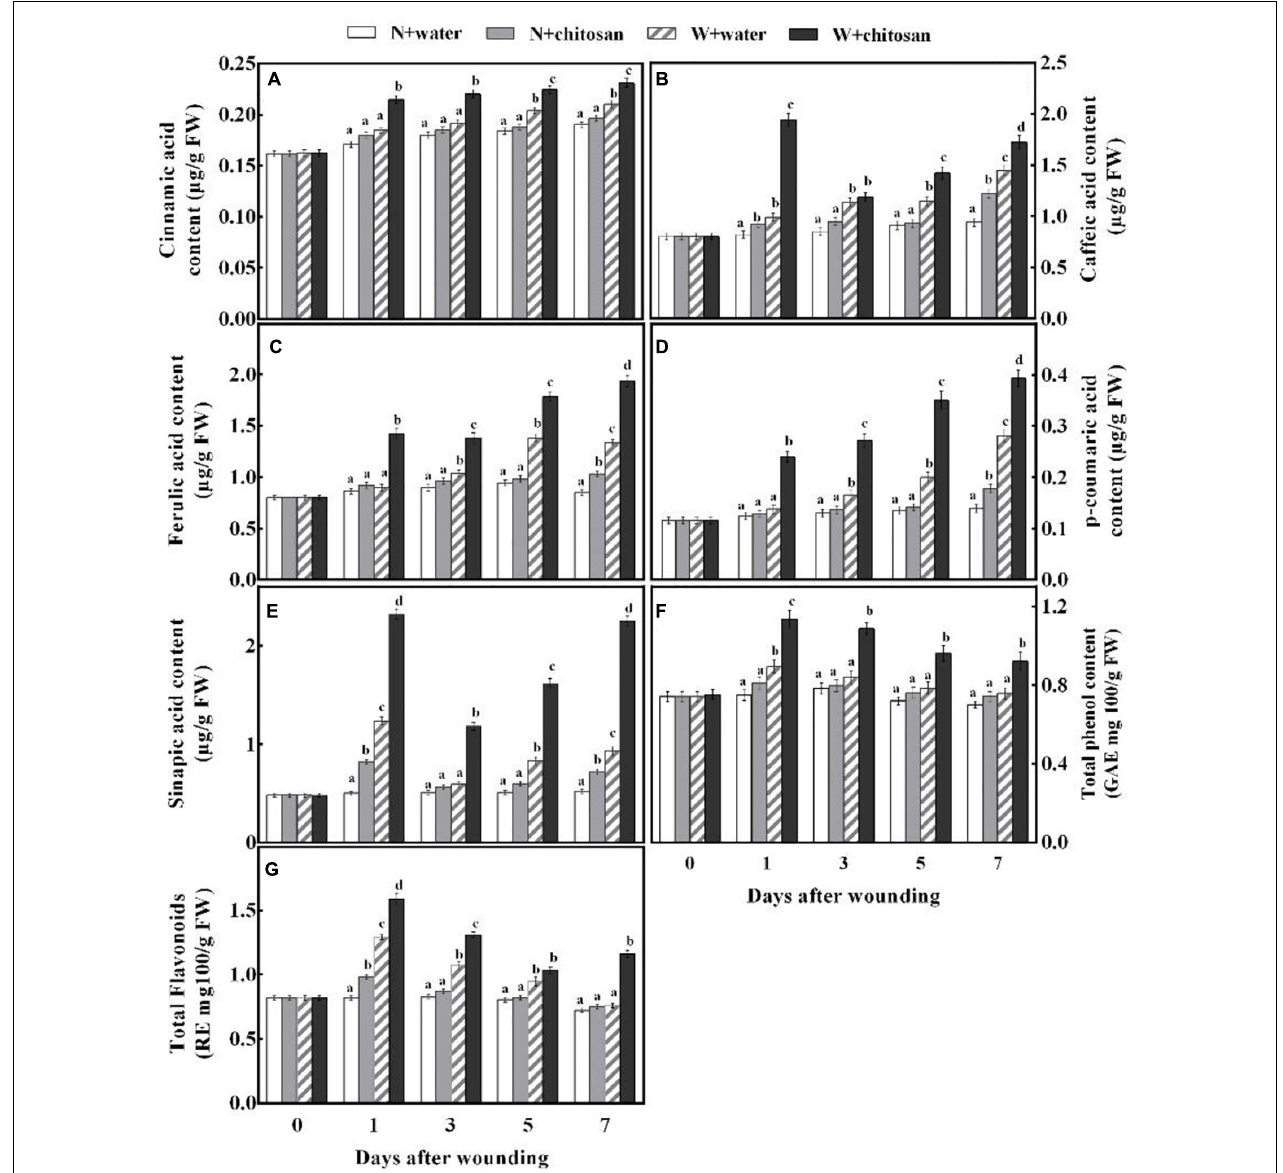
FIGURE 4 | Effect of chitosan treatment on contents of cinnamic acid (A) , caffeic acid (B) , ferulic acid (C) , p -coumaric acid (D) , sinapic acid (E) , total phenols (F) , and total flavonoids (G) . Non-wounded and treated with sterile water (N + water), non-wounded and treated with chitosan (N + chitosan), wounded and treated